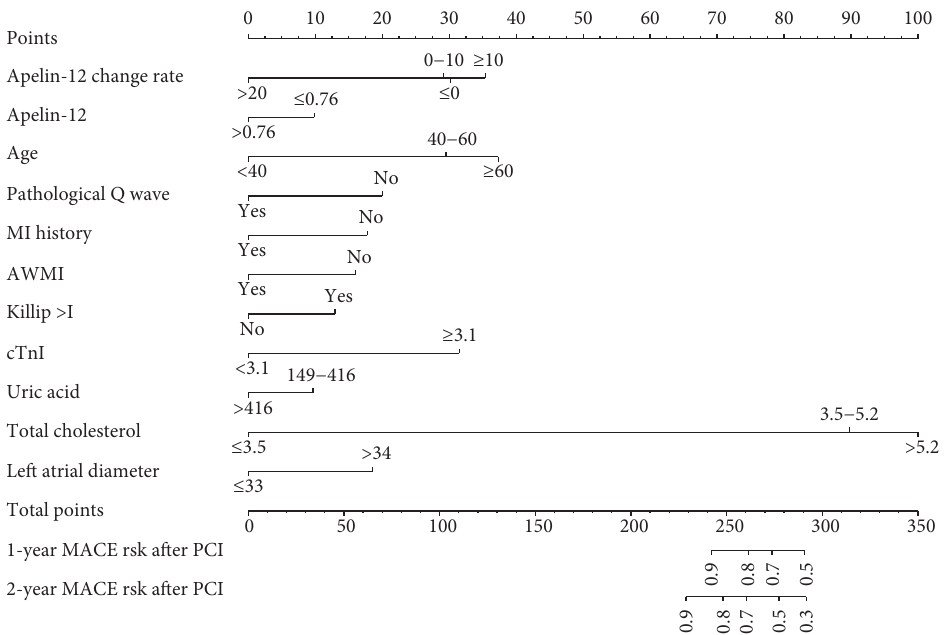
Figure 2: Nomogram predicting 1- and 2-year major adverse cardiovascular events probability for patients with ST-segment elevation myocardial infarction after primary percutaneous coronary intervention. The nomogram allows the clinician to determine the probability of the 1-year and 2-year risk for an individual patient using a combination of covariates. Using the patient’s age, you can draw a vertical line from that variable to the points scale. After repeating the process for each variable, the scores for each variable can be summed and located on the “Total Points” axis. Finally, a vertical line can be drawn straight down from the plotted total point axis to the probability axis to locate the likelihood of 1-year and 2-year